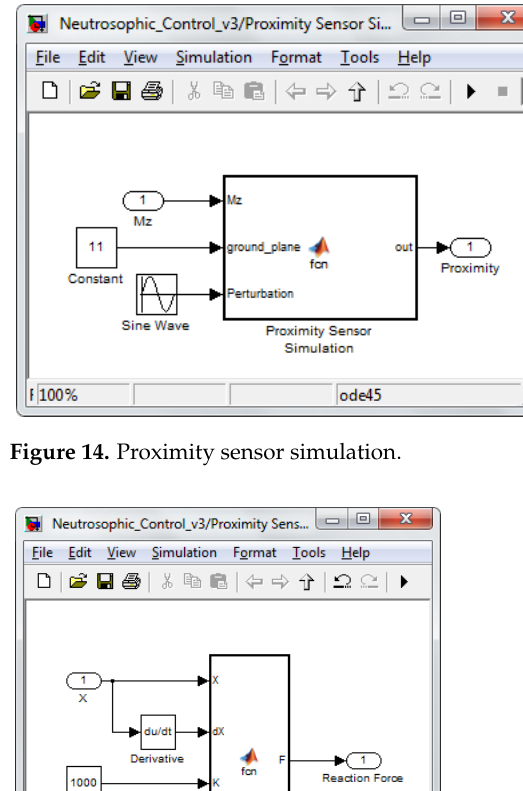
Figure 15. Force sensor simulation.